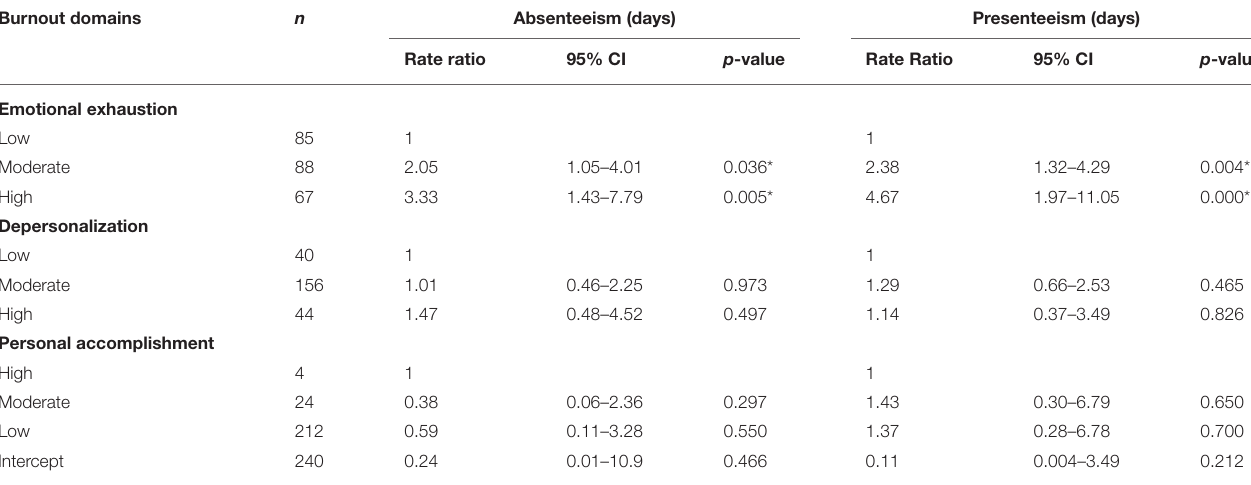
TABLE 3 | Multivariable analysis a for the association between burnout and productivity loss (absenteeism and presenteeism rates) in the studied sample ( N = 240). Burnout domains